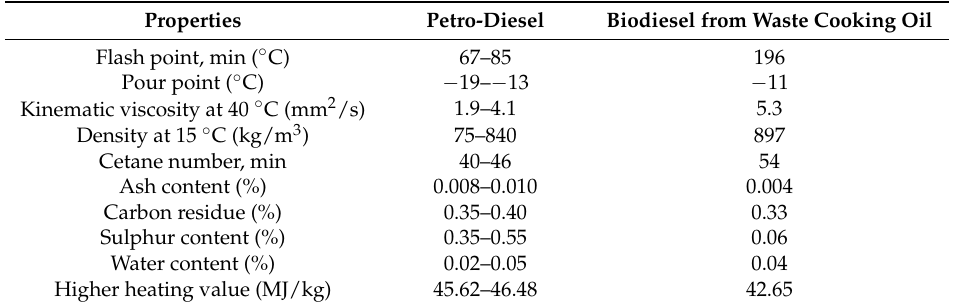
Table 3. Comparison between biodiesel and petro-diesel [41]. Reprint with permission [41]; 2009, Elsevier.